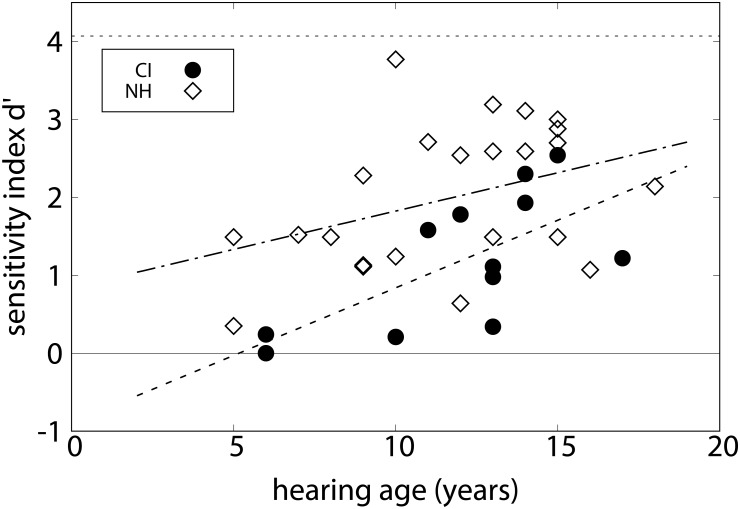
Sensitivity index d′ for experiment 1 (chord discrimination task) for individual CI (circles) and NH listeners (diamonds), as a function of hearing age. The lines show linear regressions to the data.